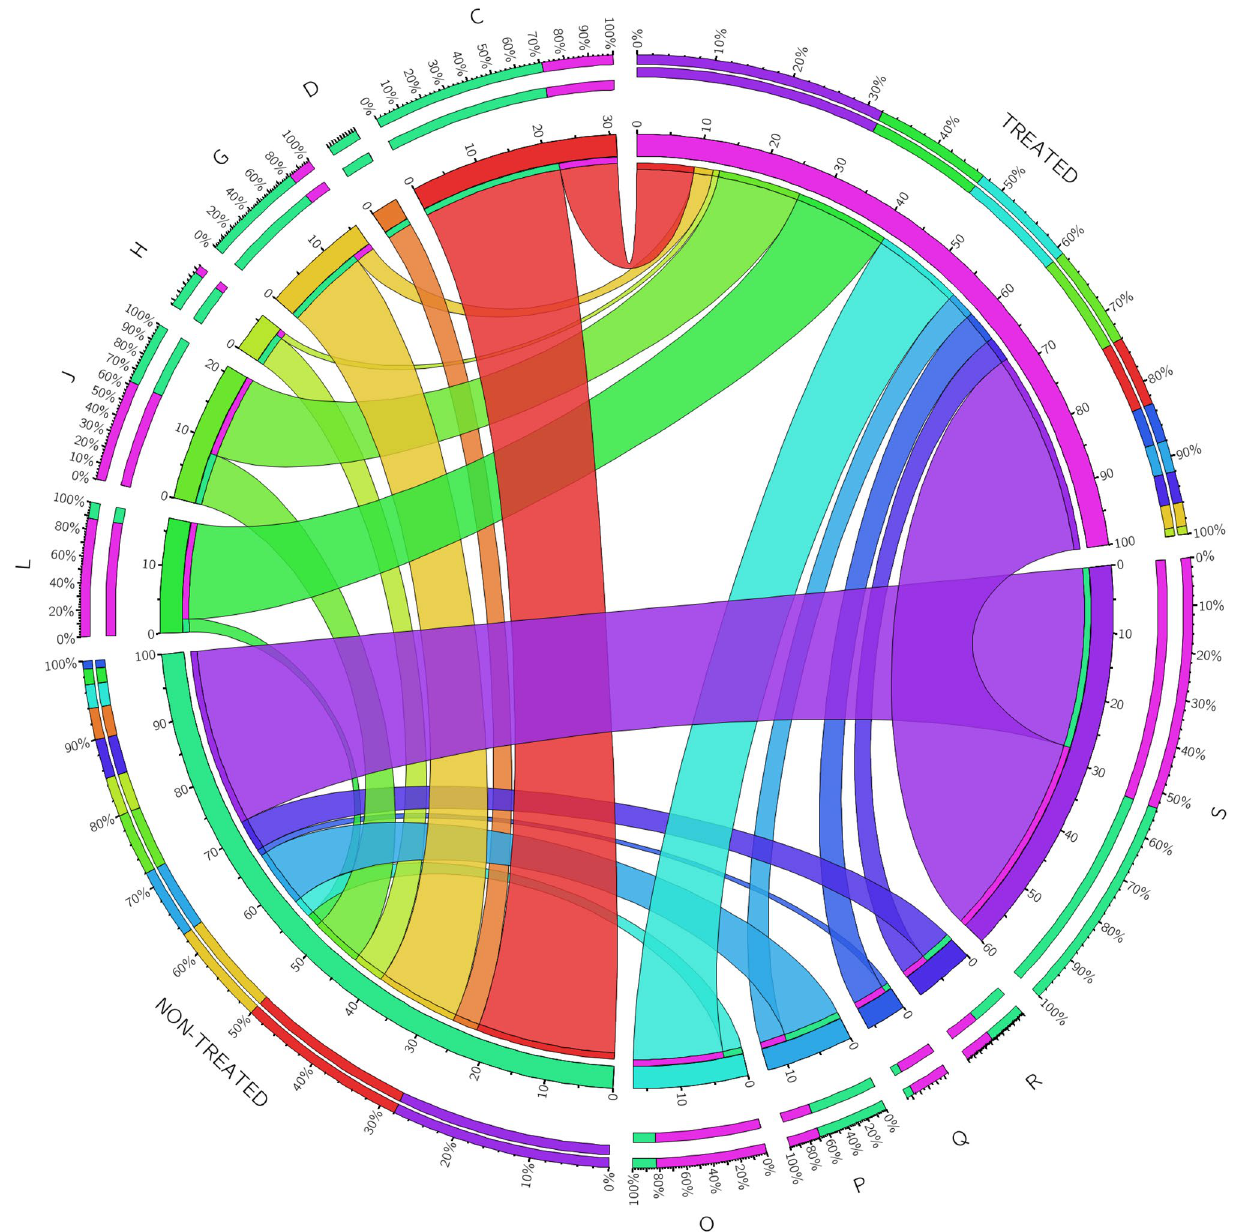
repair; Translation, ribosomal structure and biogenesis; Secondary metabolites biosynthesis, transport and catabolism; General func- tion prediction only; Carbohydrate transport and metabolism; Cell cycle control, cell division, chromosome partitioning and Energy production and